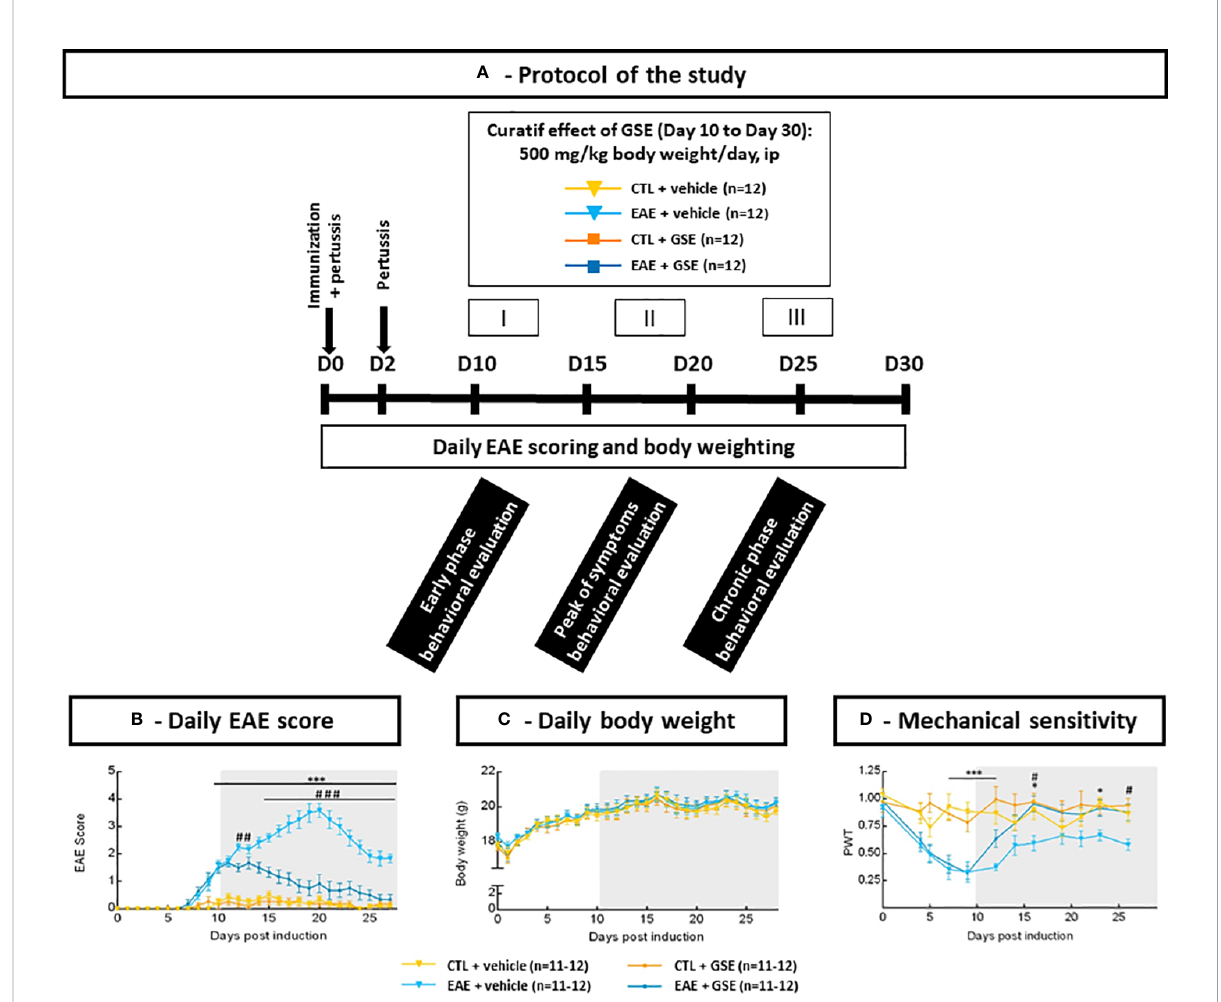
FIGURE 1 Longitudinal monitoring of clinical scores, body weight, and mechanical sensitivity in experimental autoimmune encephalomyelitis mice (EAE) and their controls (CTL) after curative treatment with grape seed extract (GSE) or vehicle. (A) Schematic representation of experimental autoimmune encephalomyelitis mice (EAE) induction, assessments, and curative chronic treatment with grape seed extract (GSE). (B) EAE clinical score was daily graded based on physical observation de fi ned by Olechowski et al. (2009), ranging from 0 (normal behavior) to 4 (hindlimb paralysis in one hindlimb or both). Results are expressed as means ± SEM. (C) Daily evaluation of body weight. Results are expressed as means ± SEM. (D) Longitudinal monitoring of mechanical sensitivity using the von Frey test. Mechanical sensitivity was expressed as the mean of paw withdrawal threshold (PWT) ± SEM for each time point. Shadowed area represents times of evaluation after GSE treatment induction. Statistical analysis was performed using two-way ANOVA followed by post-hoc Sidak ’ s test: *p < 0.05, ***p < 0.001 EAE + vehicle vs CTL + vehicle and #p < 0.05, ##p < 0.01, ###p < 0.001 EAE + GSE vs EAE +